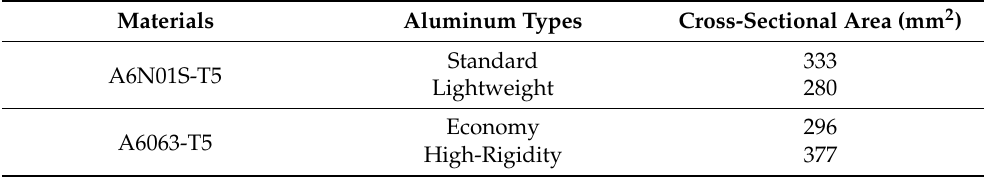
Table 3. Cross-Sectional Area of Each Type of Aluminum Frames.